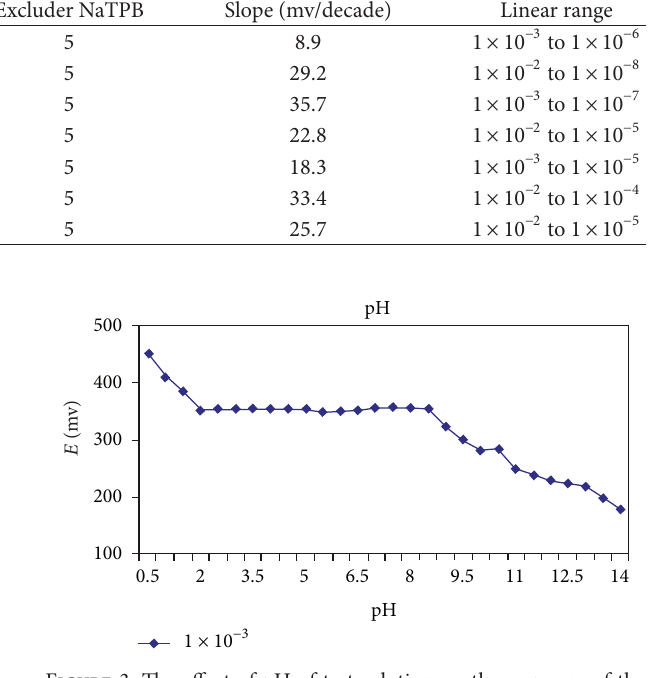
F 3: e effect of pH of test solution on the response of the ion-selective electrode. Sn 2+